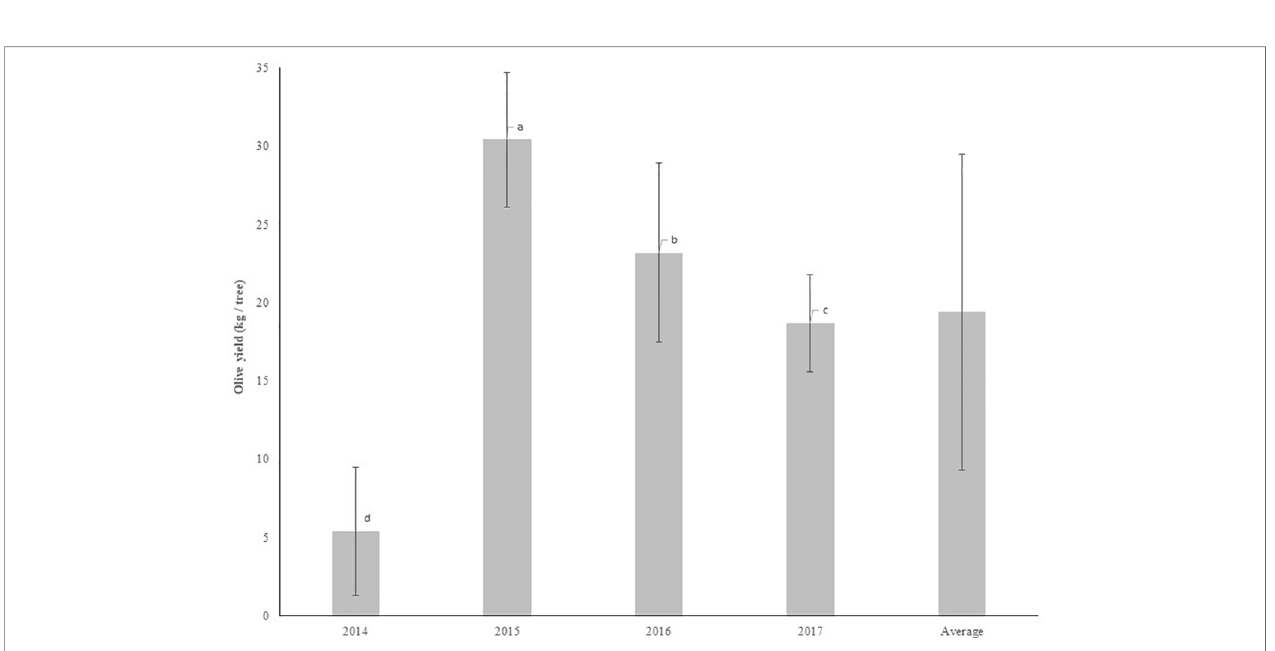
FIGURE 10 | Olive yield by year (mean±sd). Legend: T1, treatment 1; T2, treatment 2; T3, treatment 3; T4, treatment 4. Columns followed by the same letter are not signi fi cantly different by Duncan multiple range test at the 5%